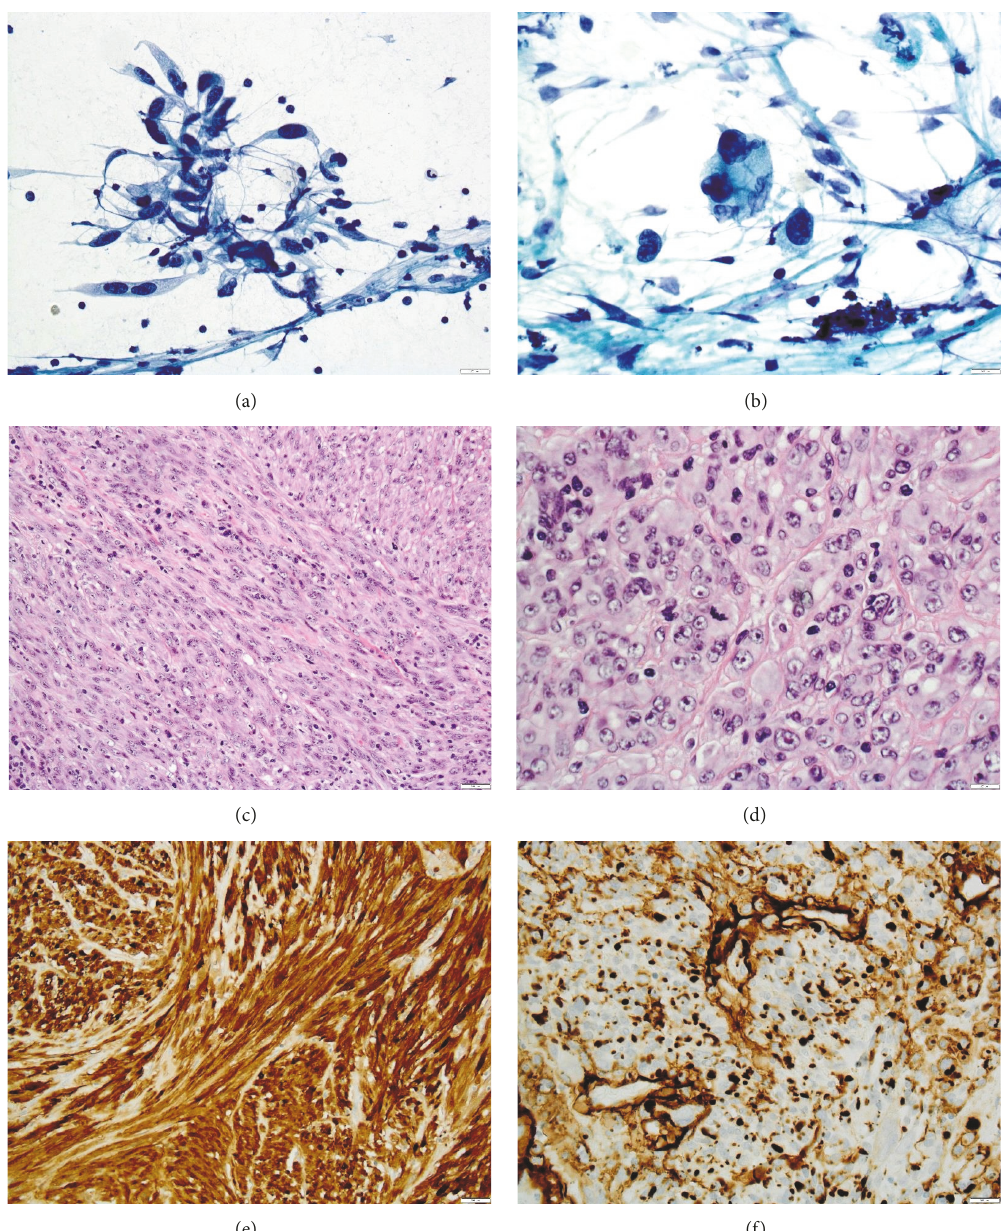
Figure 2: (a), (b) Pap-stained cytologic preparations of the right parotid-region mass; (c), (d) hematoxylin and eosin-stained sections of the parotid-region mass; immunostains for S100 (e); collagen IV